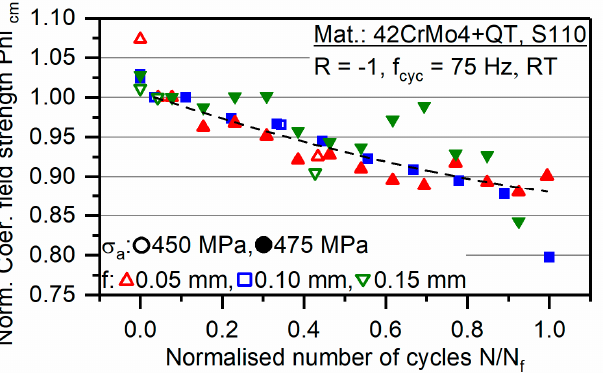
Figure 13. Normalised coercive field strength versus the normalised number of cycles for constant amplitude tests with S110 specimens and amplitudes of 450 MPa and 475 MPa.